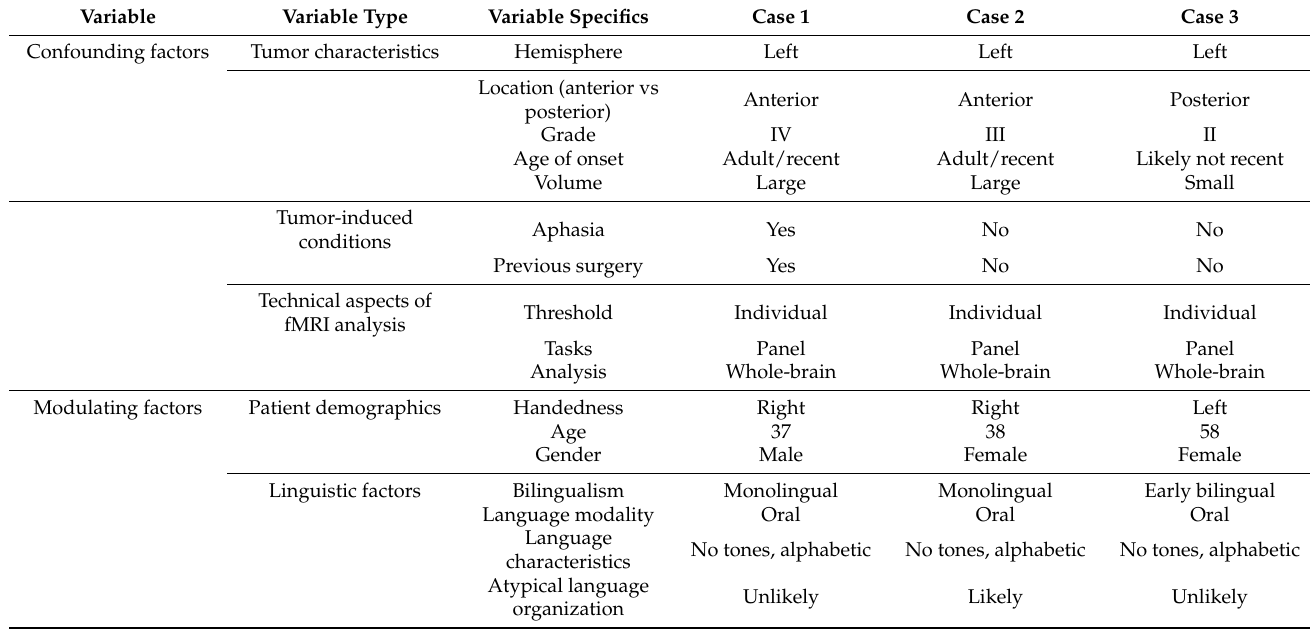
Table 3. Confounding and modulating factors in three patients with brain tumors in the left hemisphere.